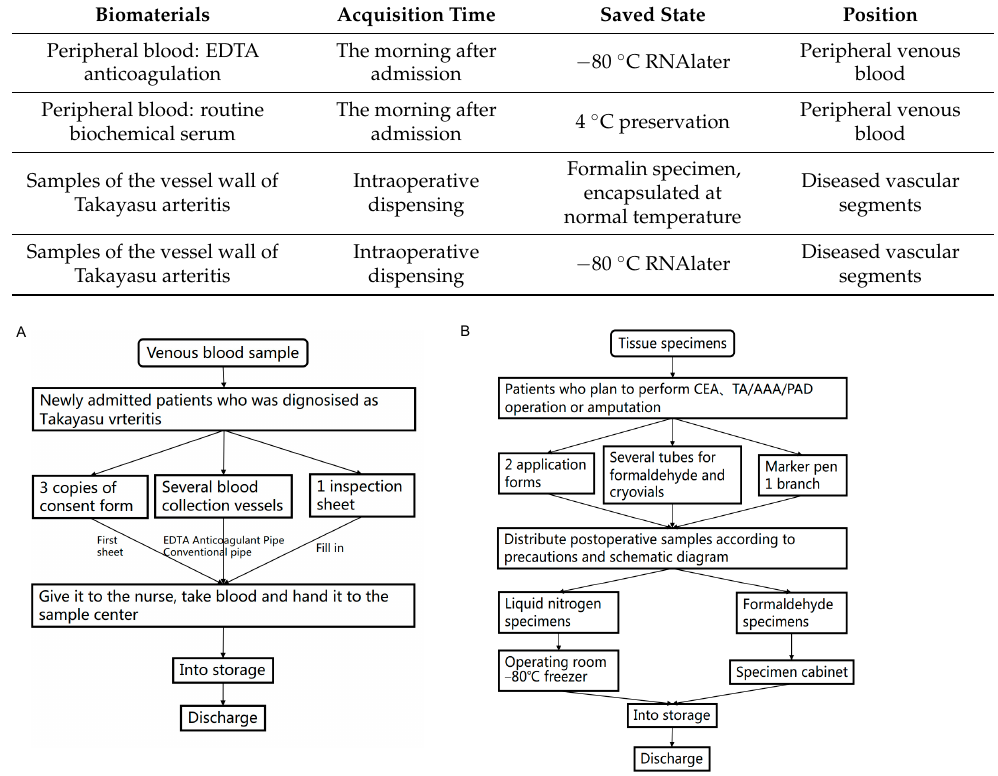
Figure 1. Collection process for Takayasu arteritis specimens. ( A ) Collection process for venous blood specimens of Takayasu arteritis. ( B ) Collection process for vascular wall tissue specimens of Takayasu arteritis.